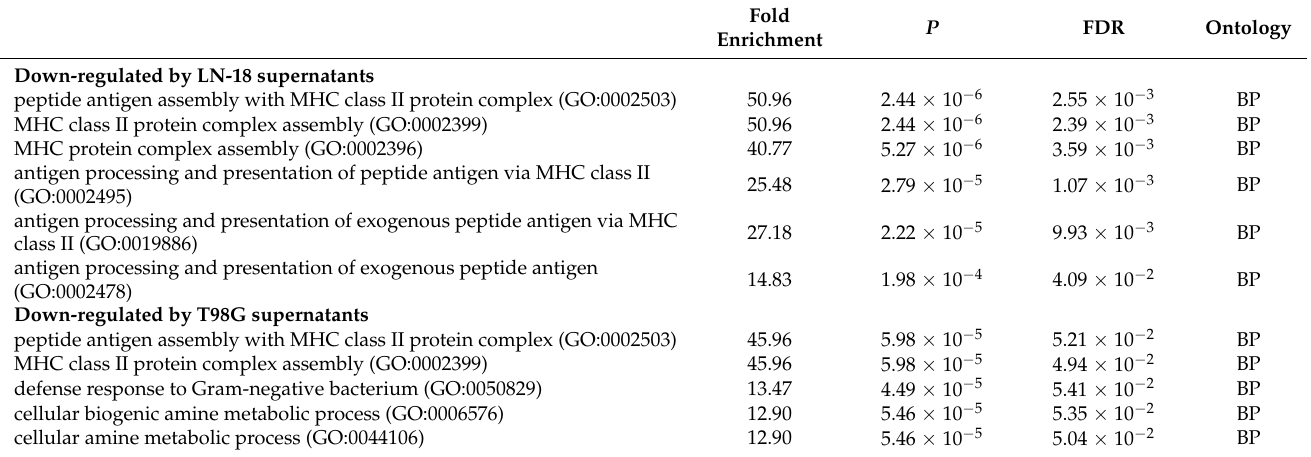
Table 3. Down-regulated GO enrichment analysis using the Panther database. Select enriched GO terms from down-regulated genes in THP-1 cells treated with LN-18 or T98G control supernatants. This is a subset of Biological Process (BP) terms from the full GO term list. GO terms are shown that had greater than 10-fold